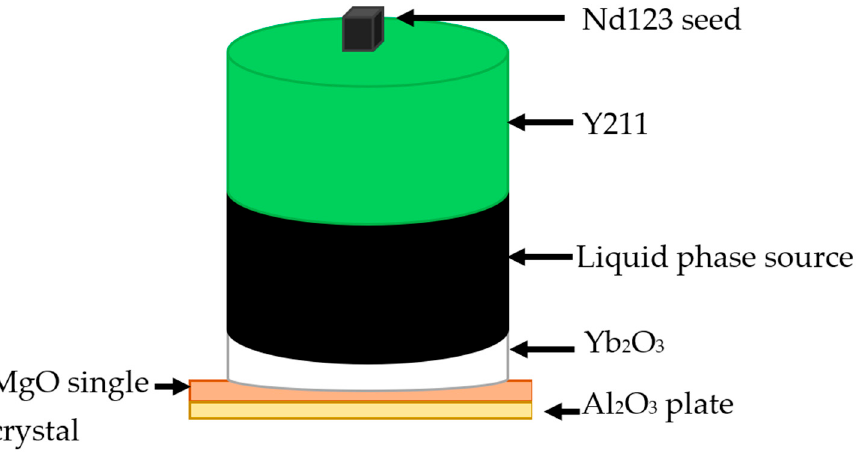
Figure 1. A schematic arrangement of the precursor sample used in the infiltration growth (IG) experiment.